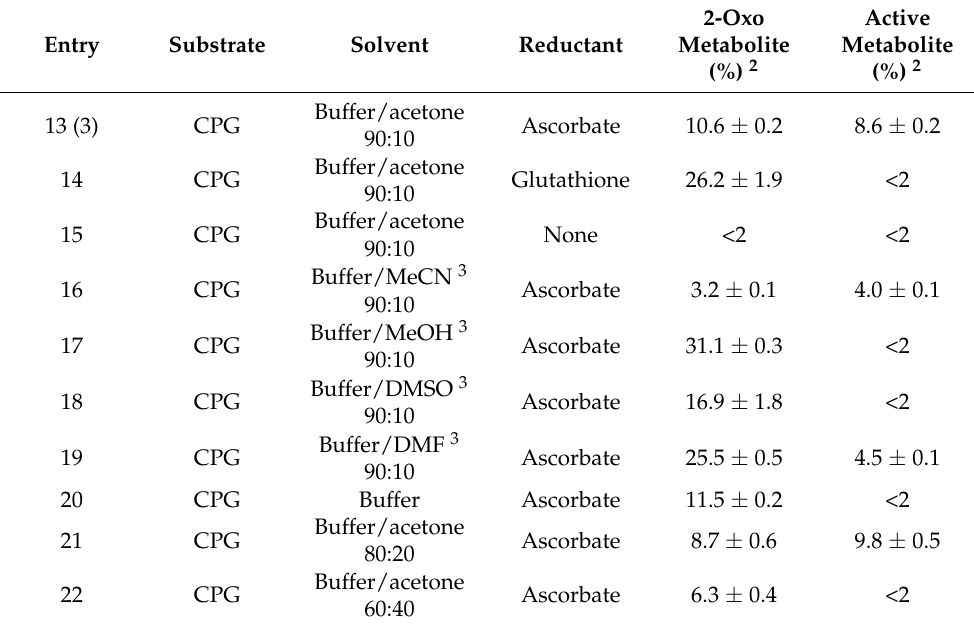
Table 2. Optimization of reaction conditions using different solvents and reductants for the conver- sion of clopidogrel (CPG) by Mro UPO 1